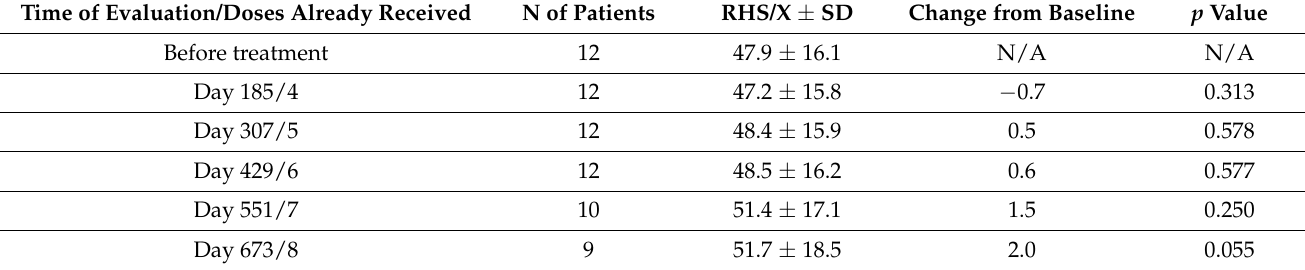
Table 5. The average RHS scores by the time points of the nusinersen injections in adult SMA type 3